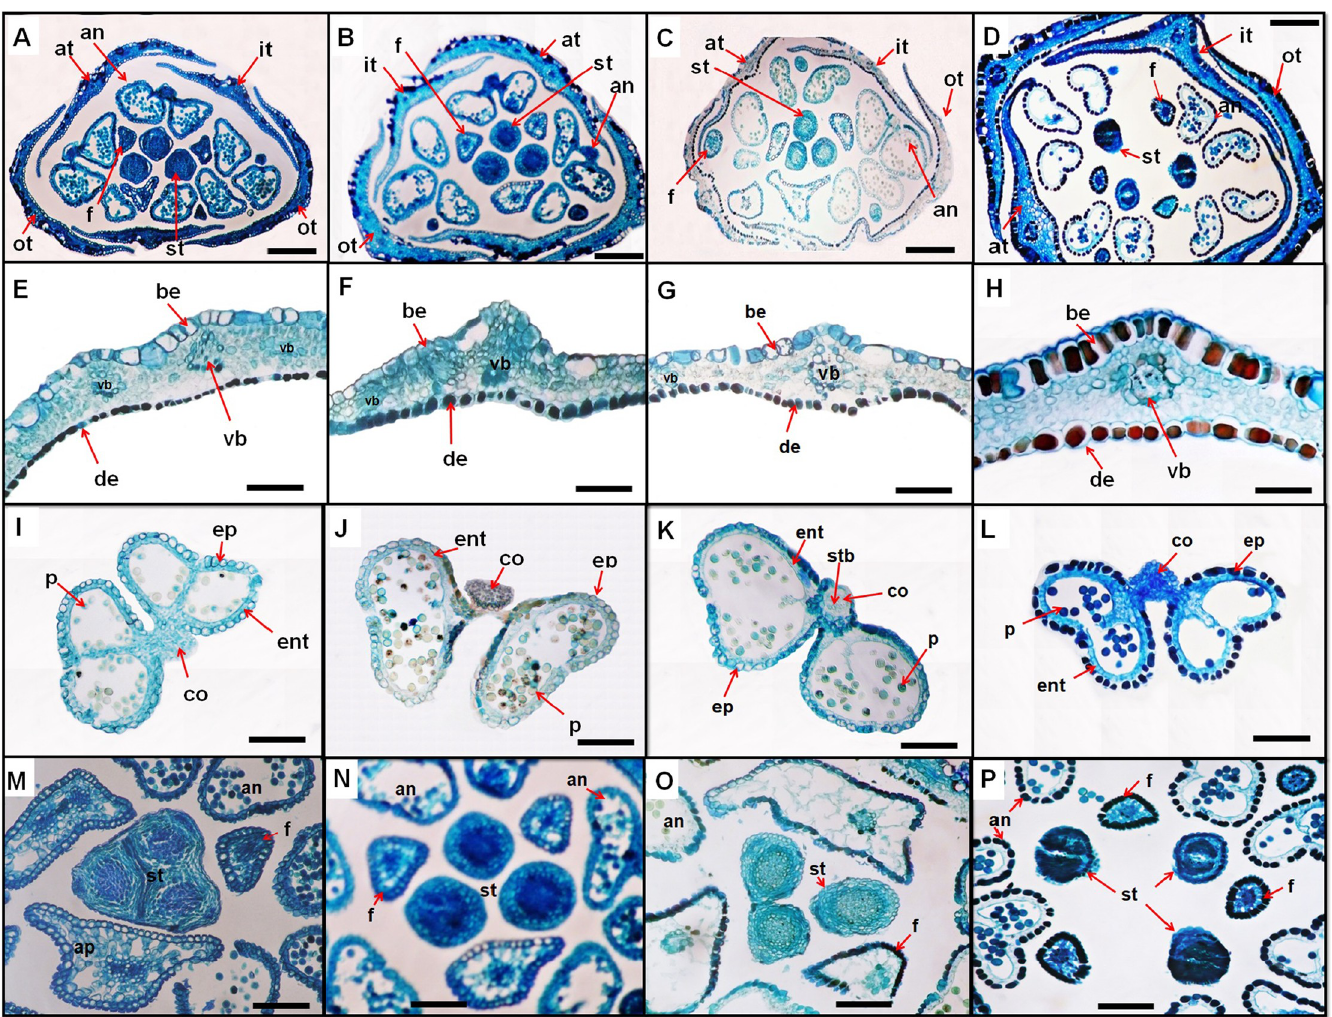
Fig 3. Anatomical aspects of the flowers. P . equisetiforme var. graecum (A, E, I and M), P . equisetiforme var. peyerinhoffi (B, F, J and N), P . aviculare (C, G, K and O), and P . maritimum (D, H, L and P) under light microscope. Flower buds cross section (A, B, C and D). Tepal detail (E, F, G and H). Detail of mature anther (I, J, K and L). Detail of the free portion of the filament and style-stigma (M, N, O and P). Abbrevations: an, anther; be, abaxial epidermis; co, connective; de, adaxial epidermis; ep, epidermis; ent, endothecium; f, filament; it, inner tepal; ot, outer tepal; at, alternate tepal; st, stigma; stb, stamen vascular bundle; p, pollen; vb, vascular bundle. Scale bars: A, B, C and D = 150 μ m; E, F, G, H, I, J, K, L, M, N, O and P = 500 μ